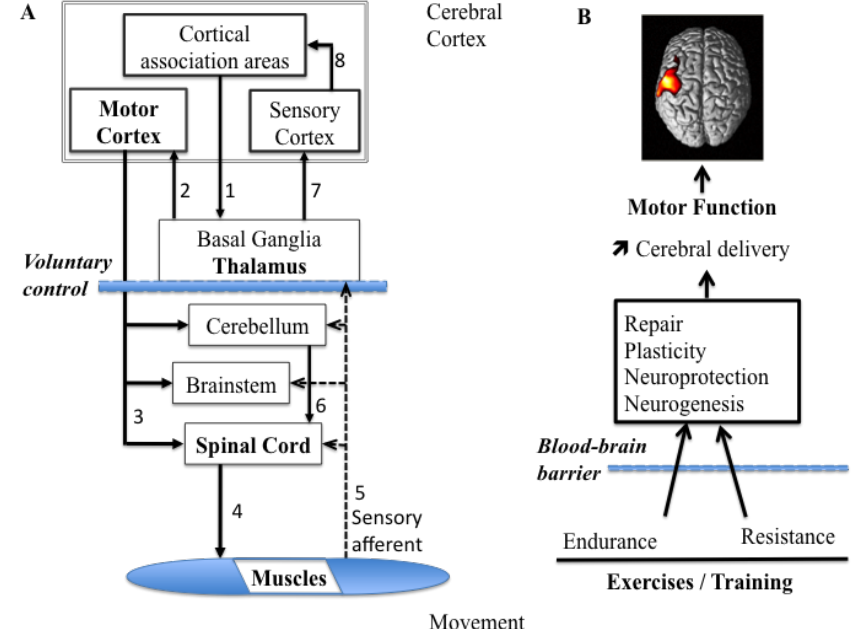
Figure 1. Diagram summarizing the control processes for voluntary movement and the influence of physical exercises on brain plasticity. ( A ) Follow the arrows and numbers from the design to the execution and then the return of feedback. Note that the cortical association areas play the key role in the design and planning of voluntary movements and the thalamus sends impulses to the motor cortex, seen as the final common pathway. Alpha motoneurons cause muscle contraction and relevant feedback information is sent towards the central nervous system (CNS). ( B ) Schematic depicting the main proposed effect of resistance and endurance exercises on CNS function. Both types of exercise lead to improvements in motor function and an increase in the cortical activation due to proper cerebral blood flow and glucose delivery to neurons. Hemodynamic changes